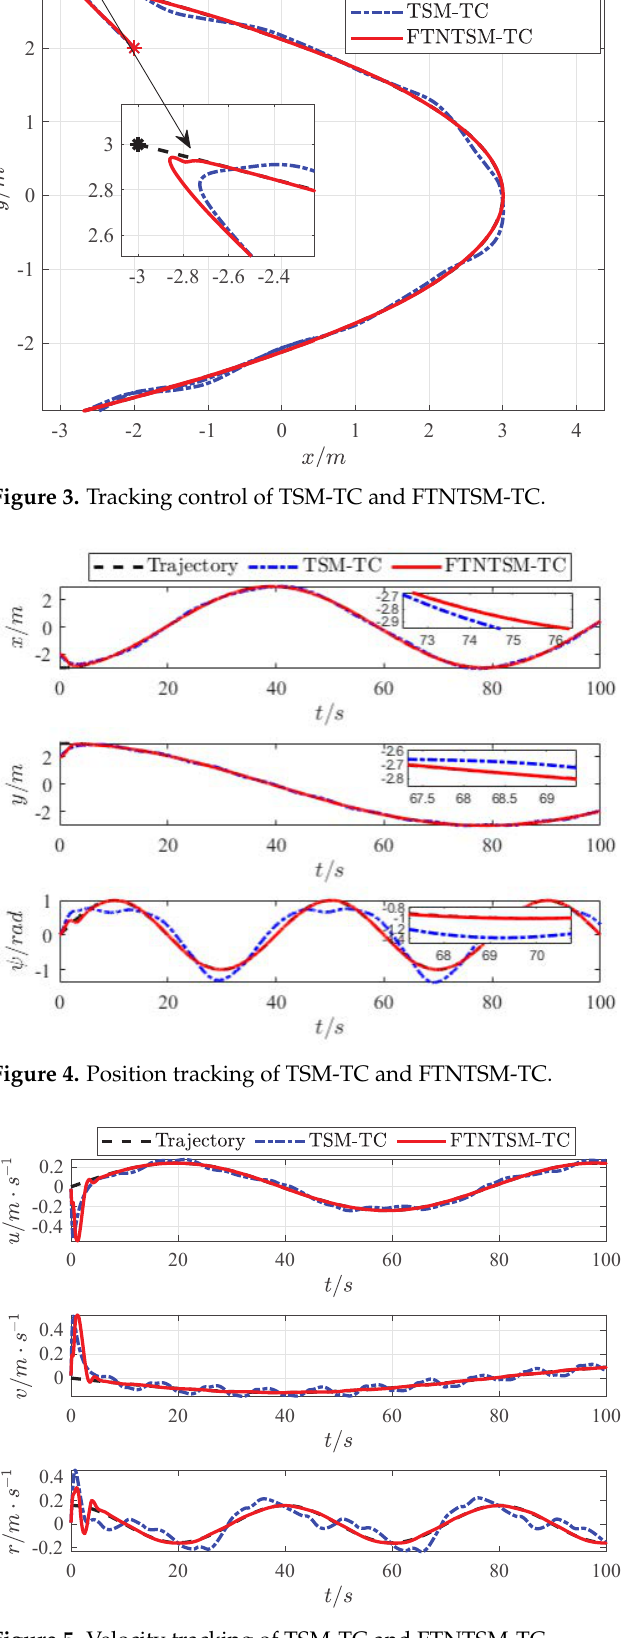
Figure 5. Velocity tracking of TSM-TC and